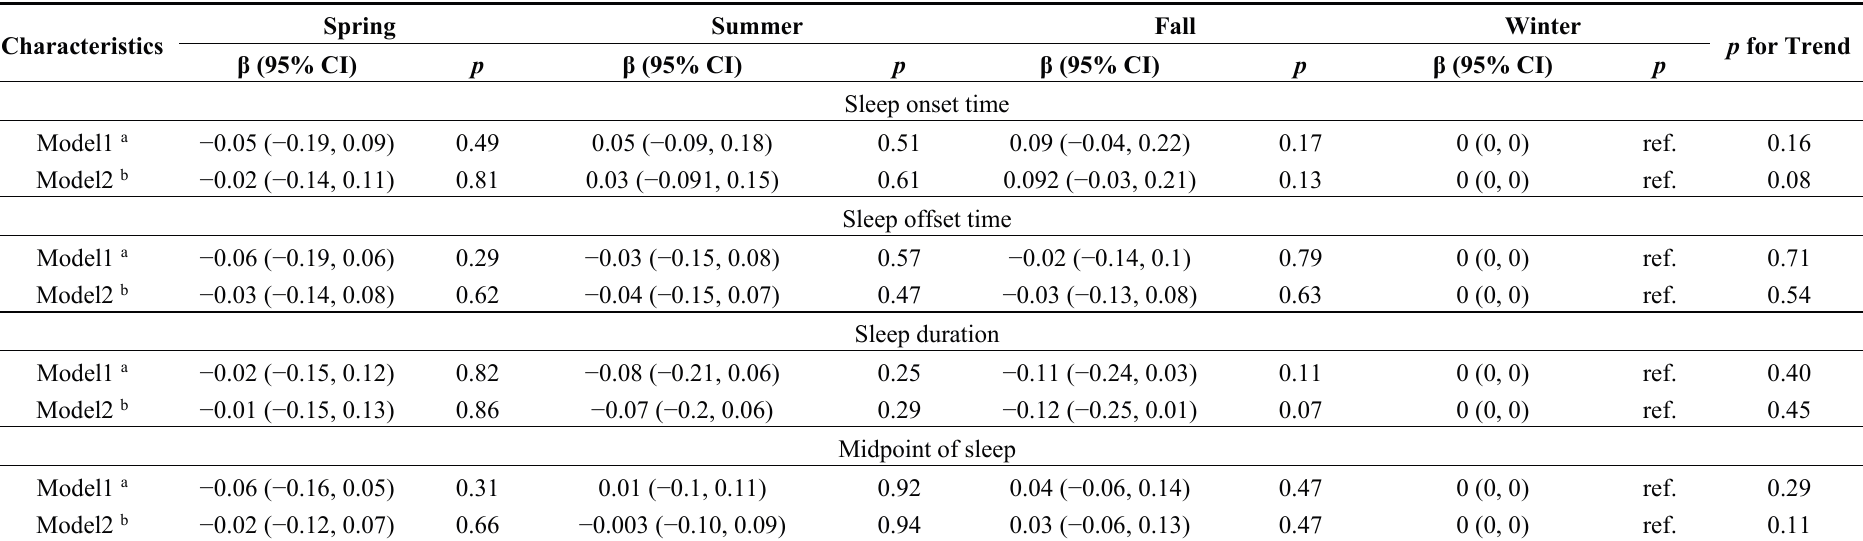
Table 3. Sleep timing preference for men by season of